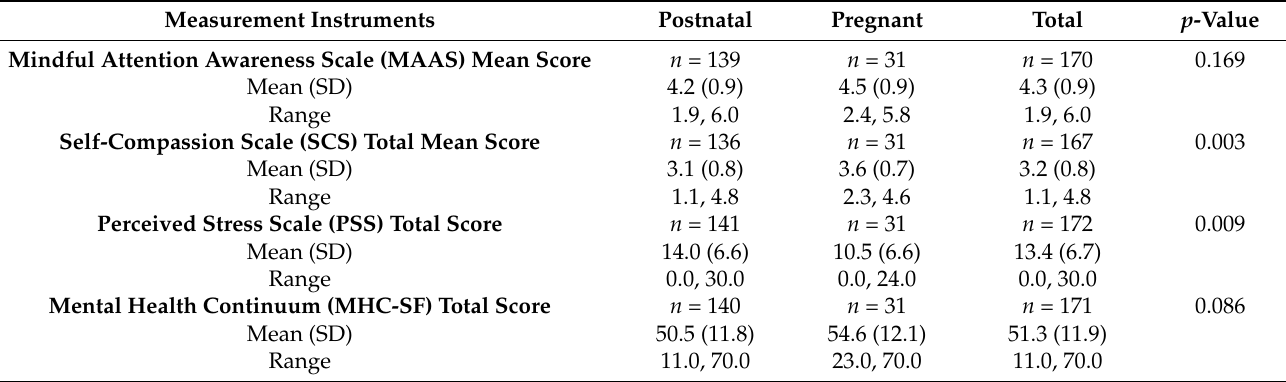
Table 1. Summary statistics for all outcome